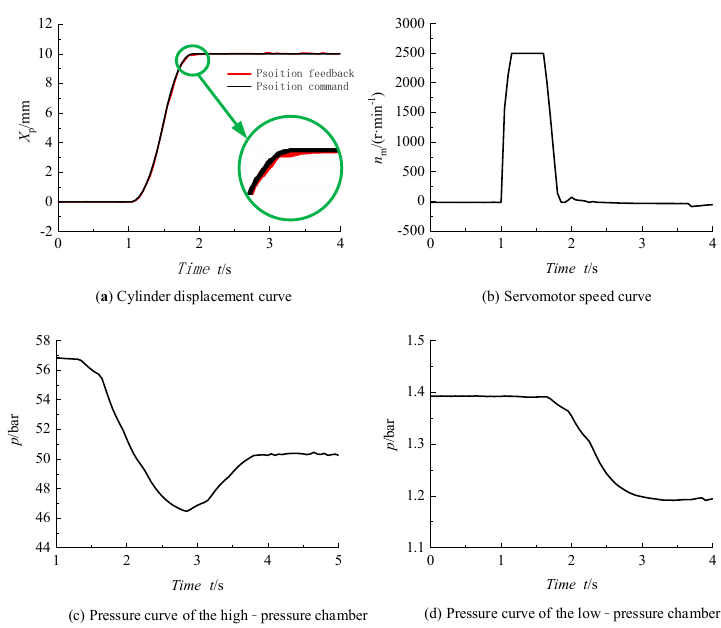
Figure 8. The response curve of valve closing test.